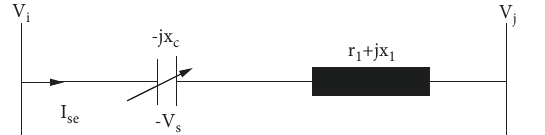
Figure 6: TCSC compensator installed on commutation lines.